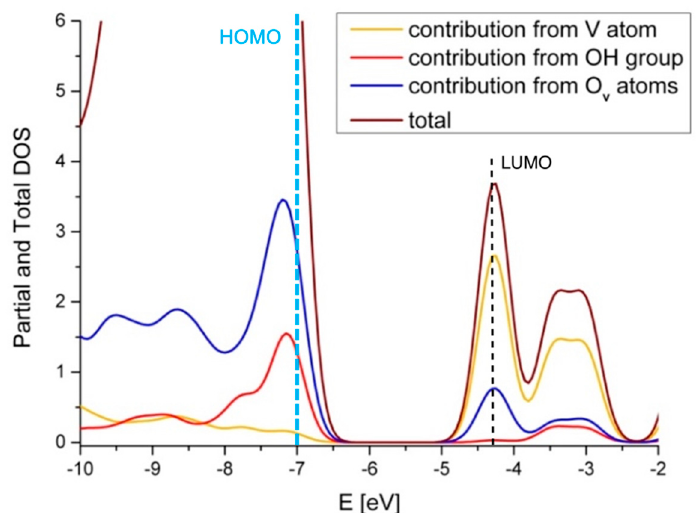
Figure 4. DOS plot of the V–OH center in the T2 position.